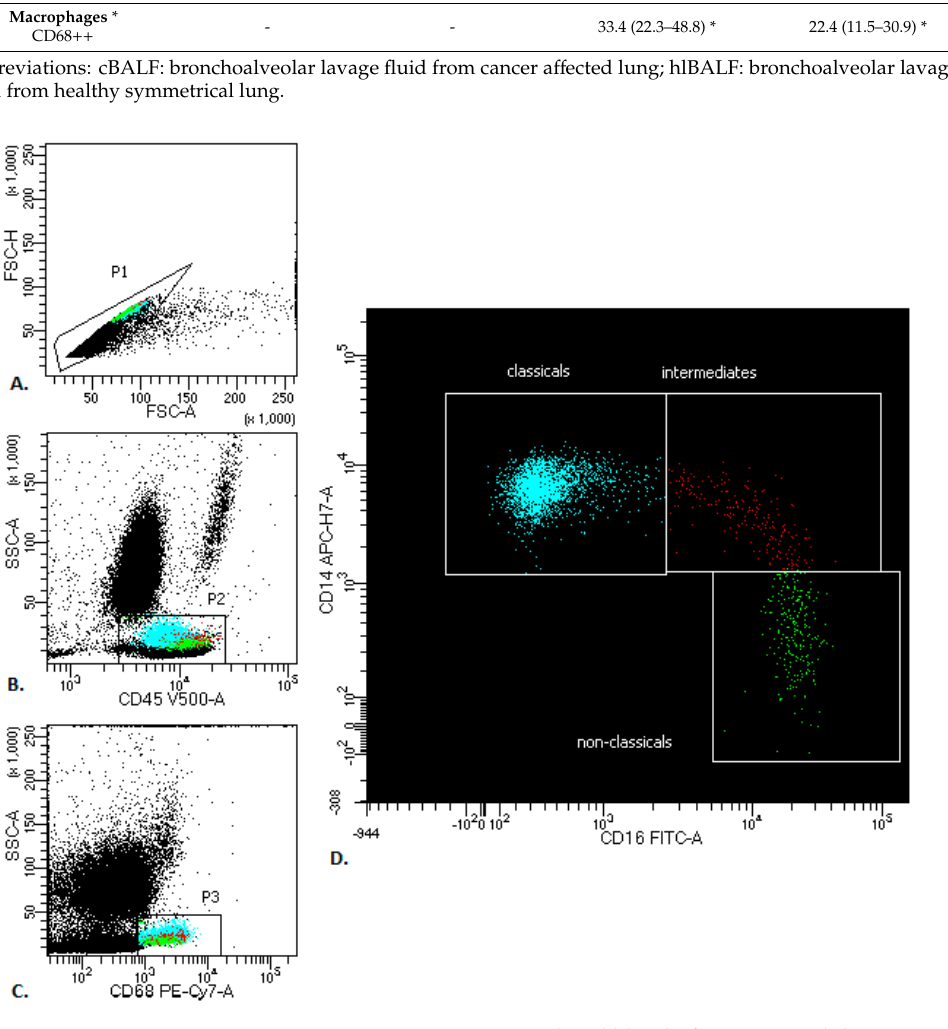
Figure 1. Representative monocyte gating strategy in peripheral blood of patients with lung cancer. ( A ) FSC-a vs. FSC-H plot: Gating the cells that have an equal area and height, thus removing clumps (greater FSC-a relative to FSC-H and debris (very low FSC). ( B ) CD45 vs. SSC-a plot: Broad selection of monocytes based on their SSC / CD45 properties. ( C ) CD68 vs. SSC-a plot: Broad selection of monocytes based on their SSC / CD68 properties. ( D ) CD16 vs. CD14 plot to gate the monocyte subsets: classicals (blue), intermediates (red) and non-classicals